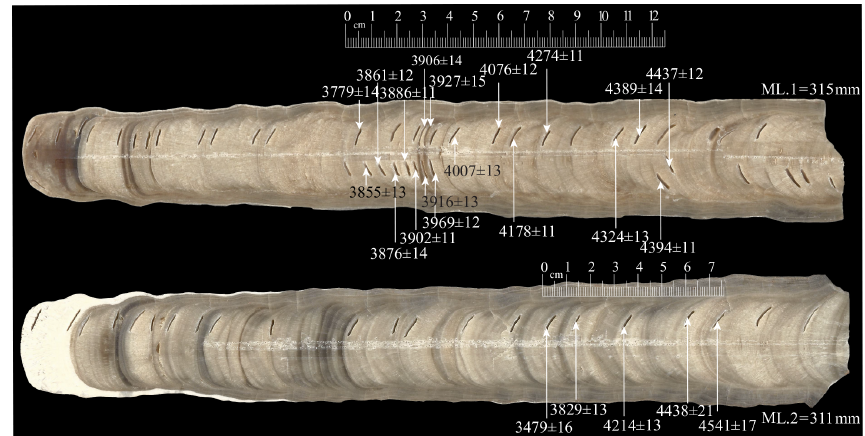
Figure 3. Samples photograph: the total length of ML.1 and ML.2 samples is 315 and 311mm, respectively. The arrows indicate the dating subsampling location and the 230 Th dates with the 2 σ analytical error (see also Tables 1 and S1). The centimeter scale indicates the location of isotopic measurements, enclosing the interval of interest within both the samples.